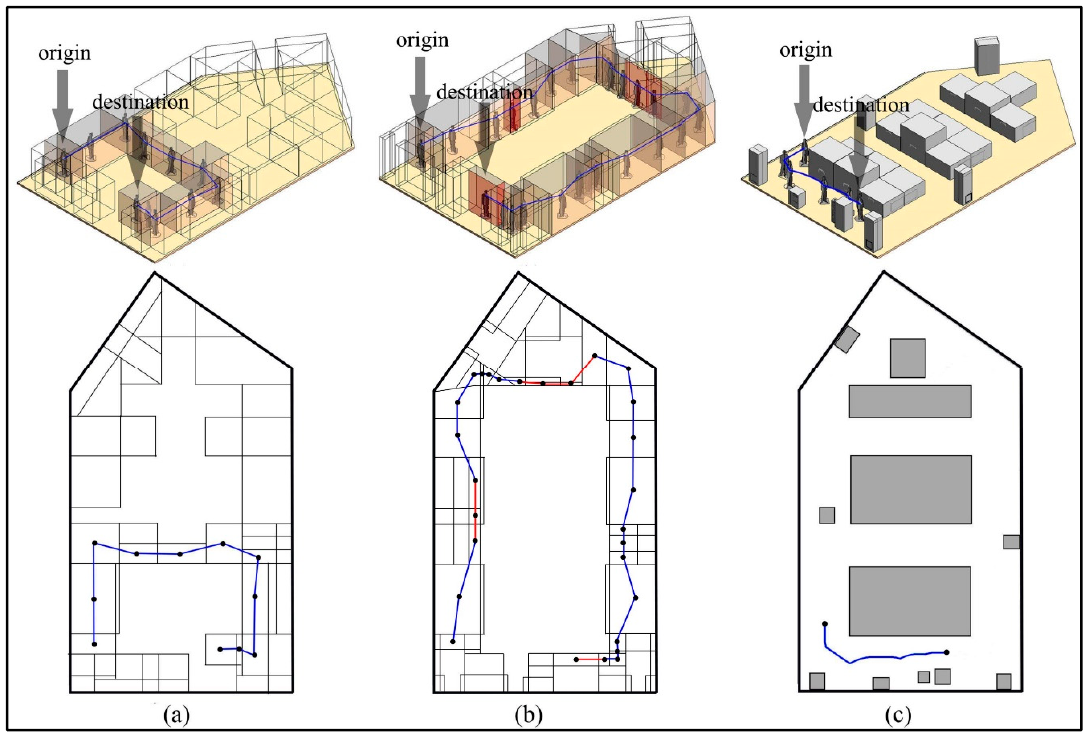
Figure 18. Generation of a navigation path. ( a ) Selected part of the connectivity graph for navigating the agent using the proposed method. ( b ) Selected part of the connectivity graph for navigating the agent using the FSS framework. ( c ) Selected part of the navigation network for navigating the agent using the AccessVOR framework.